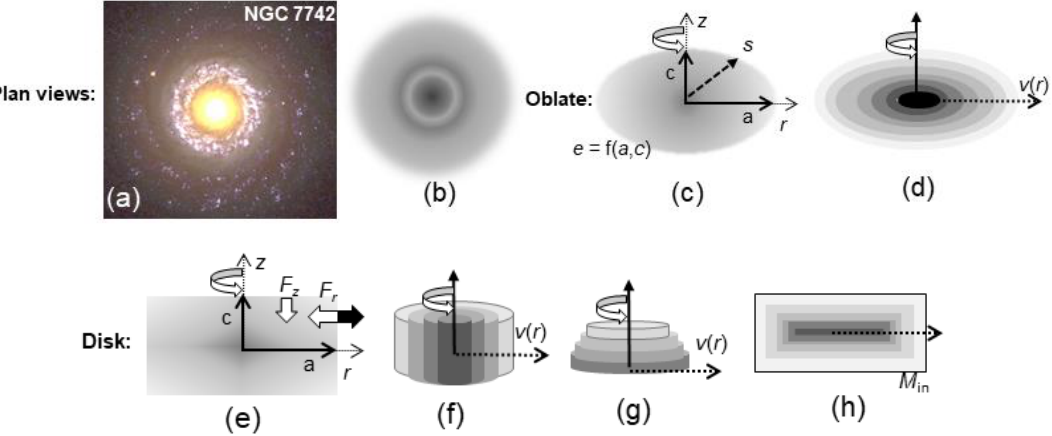
Figure 2. Geometry of spiral galaxies, as approximated in oblate spheroid and disk models: ( a ) Visual image of nearly face-on NGC 7742, type SA(r), by the Hubble Heritage Team (AURA/STScI/NASA), and publicly available from http://hubblesite.org/newscenter/archive/releases/1998/28/image/a/). This particular ring galaxy is counter-rotating [37]; ( b ) Schematic of graded density in the equatorial plane; ( c ) Geometry of a spinning, oblate spheroid; ( d ) Side view of homeoids of constant density and shape which nest to form the oblate; ( e ) Geometry and gravitational forces (white arrows) for a disk of finite thickness and radius. Although the horizontal gravitational forces would be balanced by the centrifugal pseudo-force (solid arrow), the force along z is unopposed at any finite distance above the equatorial plane; ( f ) The basis of ring models: perspective view of concentric cylinders of various density (gray) rotating about the z -axis. Density and velocity gradients are co-linear; ( g ) Perspective view of stacked disks rotating about the z -axis, which describes density varying vertically; ( h ) Side view of the assembly of a thick disk with graded density. Nested hollow pillboxes are the required shape for isodensity contours in thick disk geometry.